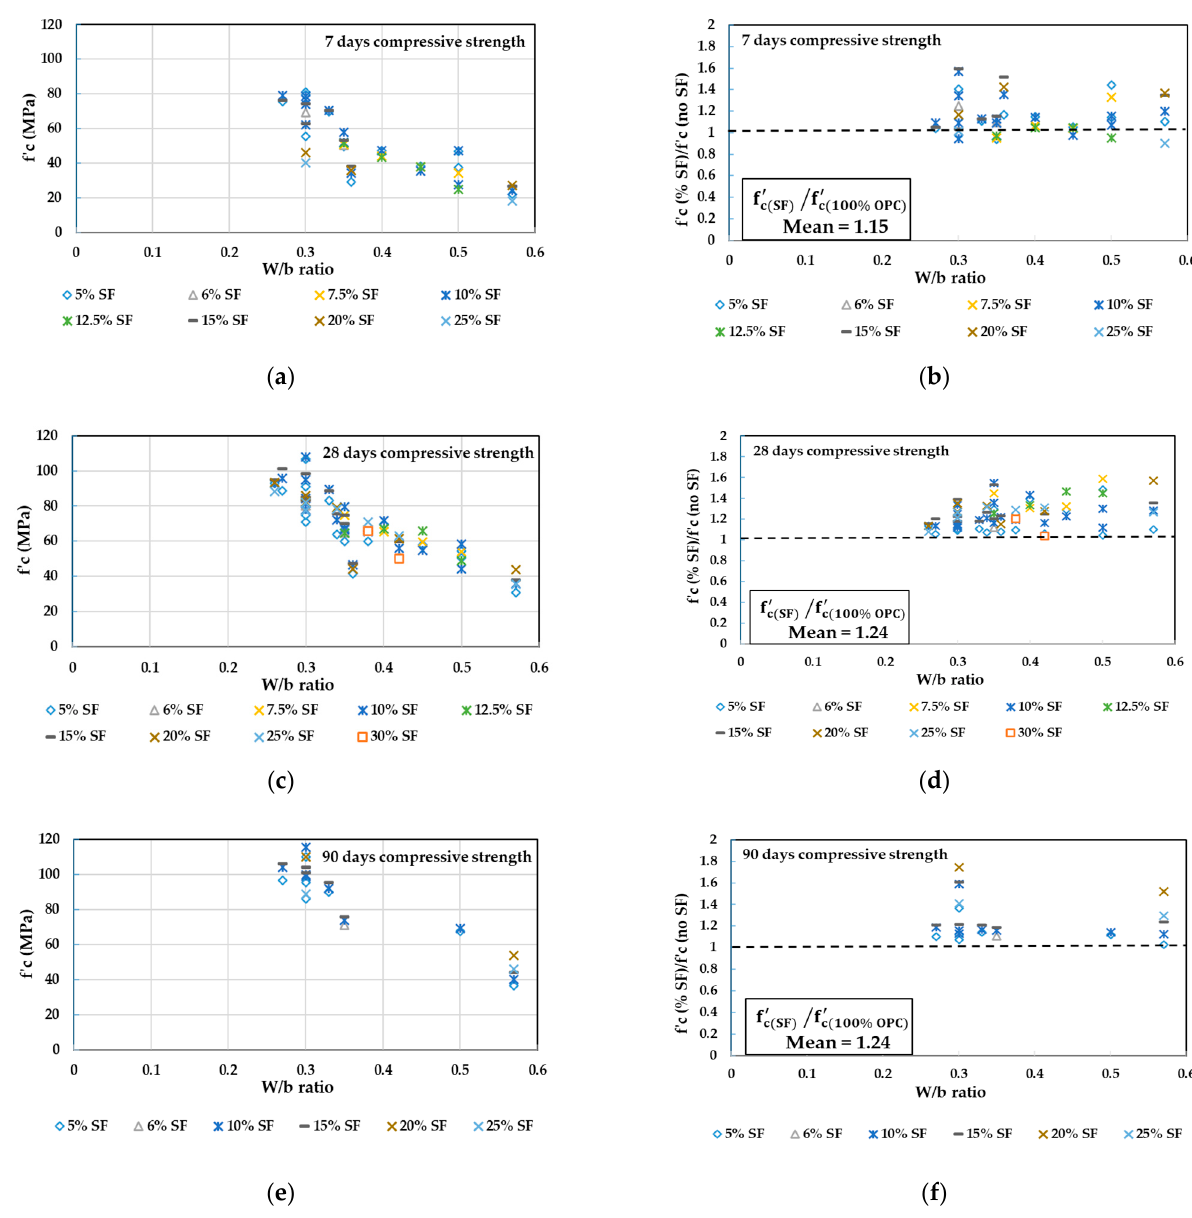
Figure 4. Concrete with Silica fume (SF) as a partially replacing material for cement. Compressive strength vs. W/b ratio at ( a ) 7 days; ( c ) 28 days; ( e ) 90 days. Ratio between compressive strength of concrete with SF to concrete without SF at ( b ) 7 days; ( d ) 28 days; ( f ) 90